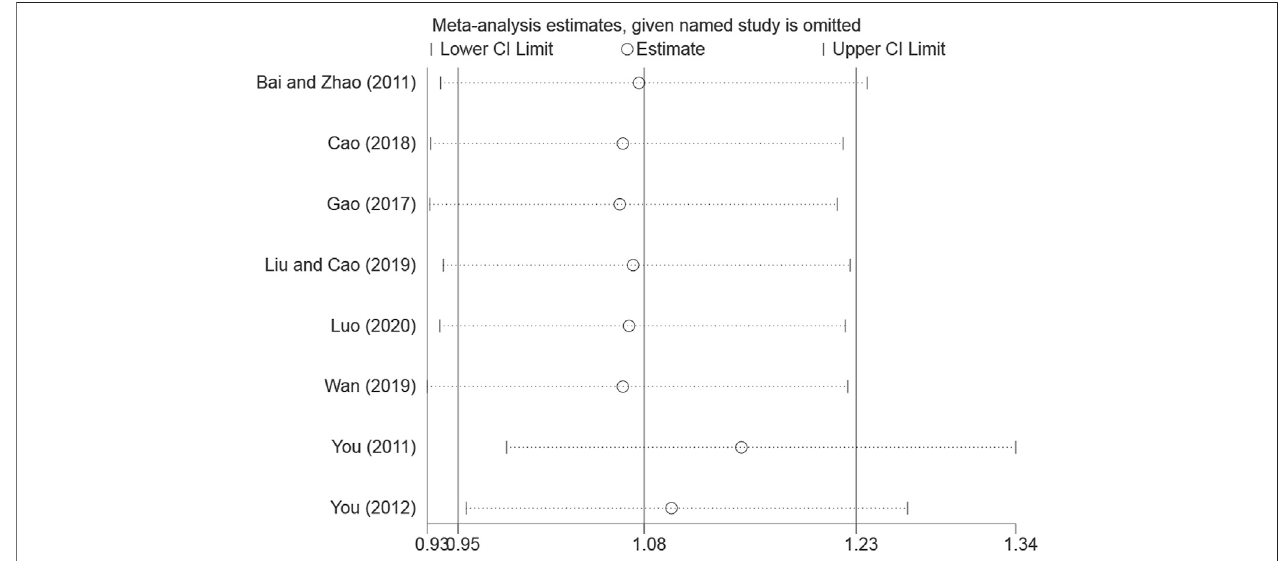
FIGURE 11 | Sensitivity analysis of the overall response